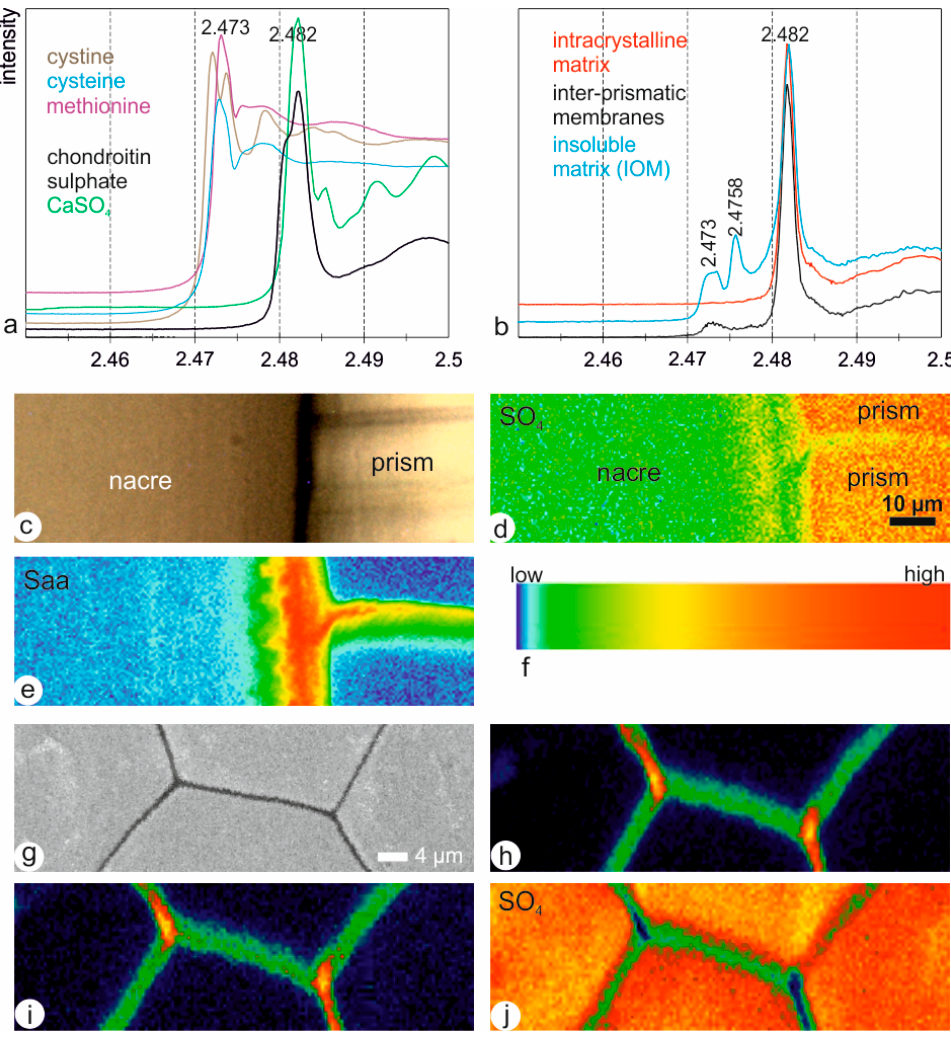
Figure 11. X-ray absorption near edge structure (XANES), Pinna shell. ( a ) Spectra of organic and mineral standards. ( b ) In situ spectra of the intra-crystalline part of the prisms and of the inter-prismatic organic membranes, and spectrum on the insoluble organic matrix extracted from the prismatic layer. ( c ) Longitudinal section showing the prismatic and the nacreous layer, and the inter- and intra-prismatic organic membranes. ( d ) XANES distribution map of sulphate (SO 4 ) (E = 2.482 keV). ( e ) XANES distribution map of sulphur rich aminoacid (Saa) (E = 2.473 keV). ( f ) Color scale of XANES maps. ( g ) Transversal polished section used for XANES maps. ( h ) XANES distribution map of sulphur rich aminoacid (E = 2.473 keV). ( i ) XANES distribution map of sulphur rich aminoacid (E = 2.4758 keV). ( j ) XANES distribution map of sulphate (SO 4 ) (E = 2.482 keV).